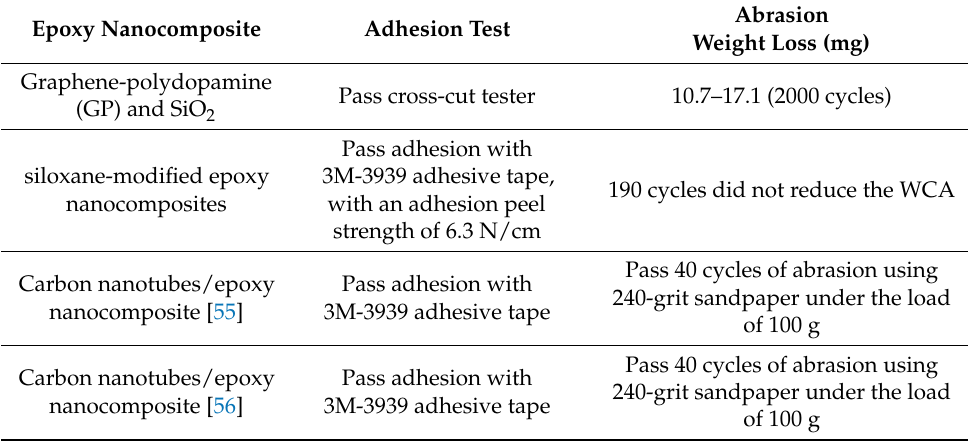
Table 4. Reported data on the durability of other epoxy nanocomposite